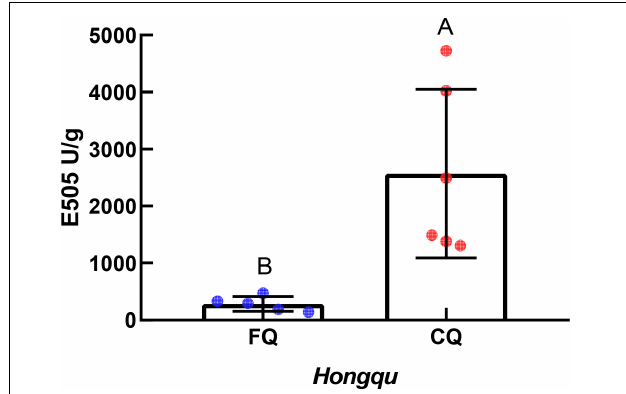
TABLE 2 | The content of MK in Hongqu (mg/g).